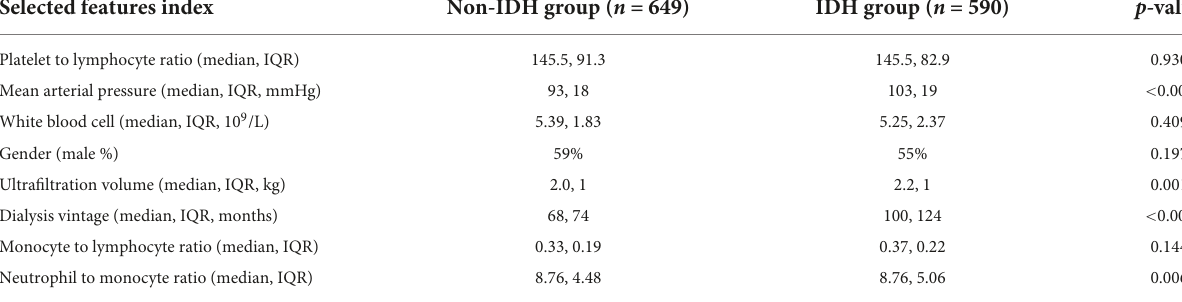
TABLE 22 Clinical features selected by in IDH and Non-IDH